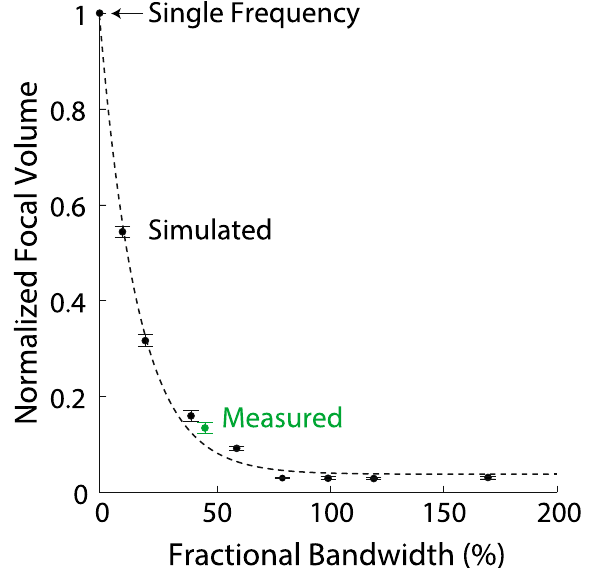
Figure 4. MFS gains as a function of available bandwidth. Mean ± s.d. focal volume as a function of fractional bandwidth, relative to the single frequency case (0% bandwidth). The data are provided separately for simulations for each datapoint (black; n = 7 ), and the measurement of Fig. 2b (green). The black dotted line − 0.06 x represents an exponential fit to the data ( f ( x ) = e